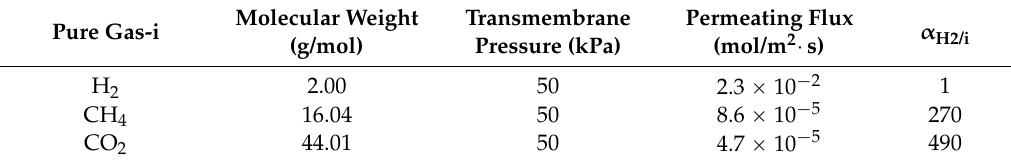
Table 3. A comparison between the long term characteristics of different Pd ‐ Au membranes